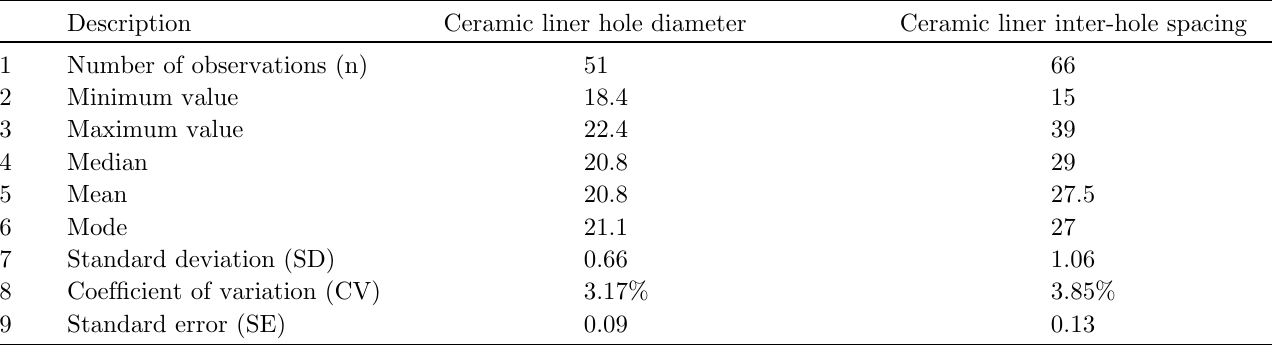
Table 3. Central tendency, dispersion and measure of